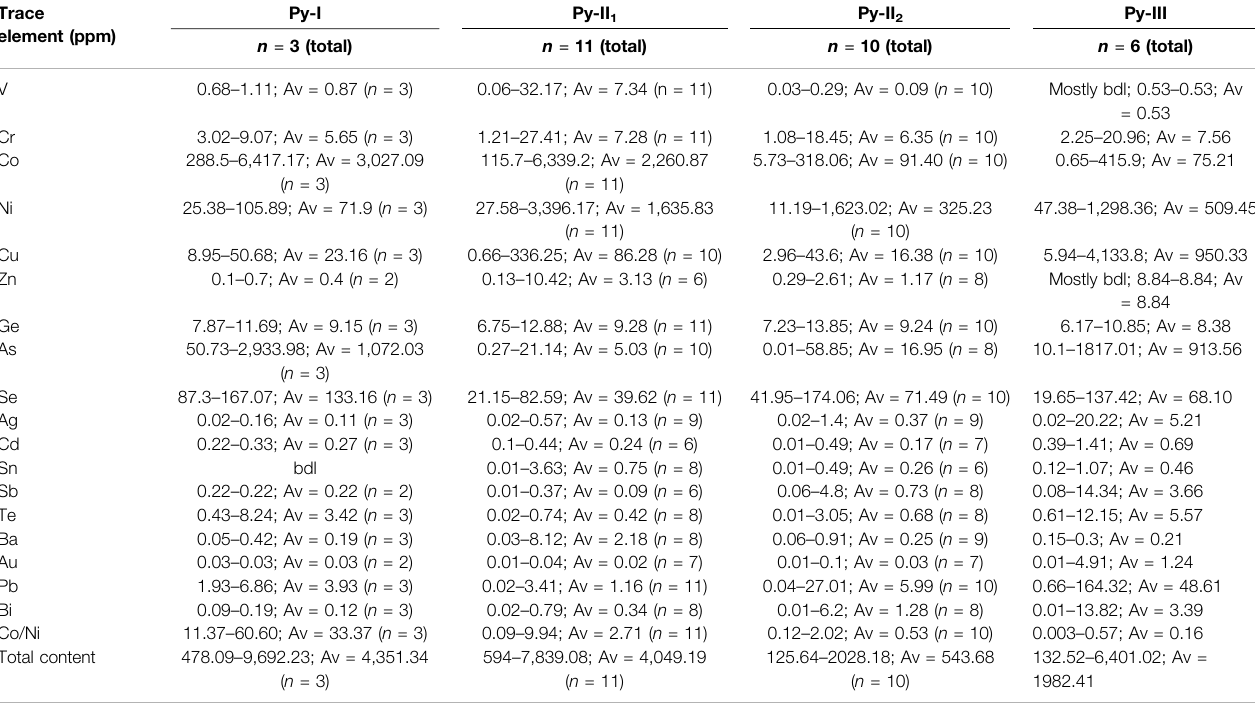
TABLE 1 | In situ trace element compositions of pyrite for different metallogenic stages of the Tuwu porphyry Cu deposit in eastern Tianshan, Xinjiang, NW China (ug/g). Trace element (ppm)